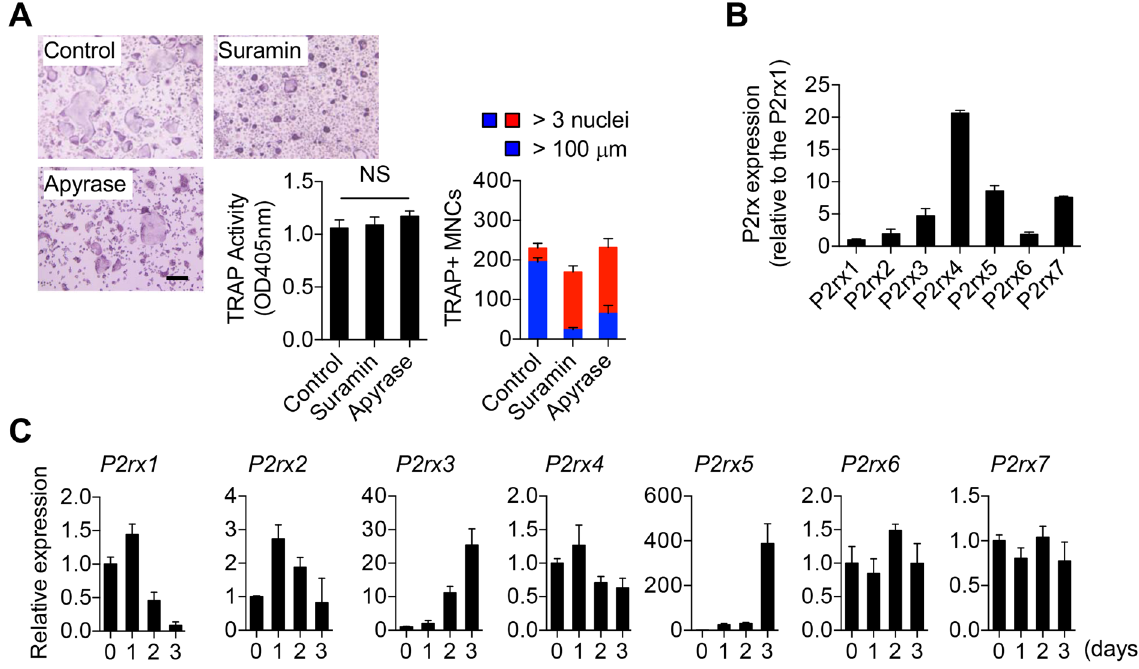
Figure 2. Function and expression of purinergic receptors during osteoclast maturation. ( A ) Effect of the purinergic receptor antagonist suramin on OC differentiation. BMMs were cultured for 3 days + / − suramin (20 μ M) in the presence of M-CSF (30 ng/ml) and RANKL (150 ng/ml). Cells were then stained for TRAP and observed by microscopic examination. OCs with more than 3 nuclei and 100 μ m in size were counted. Scale bar, 100 μ m. NS, not significant. ** P < 0.01, *** P < 0.001. Data are shown as means ± SD. ( B ) Comparative expression of P2rx subfamily members in mature OCs as determined by qPCR analysis of mRNA. ( C ) Relative induction of P2rx subfamily members during OC differentiation/maturation culture as determined by qPCR analysis of mRNA. Data are shown as means ±